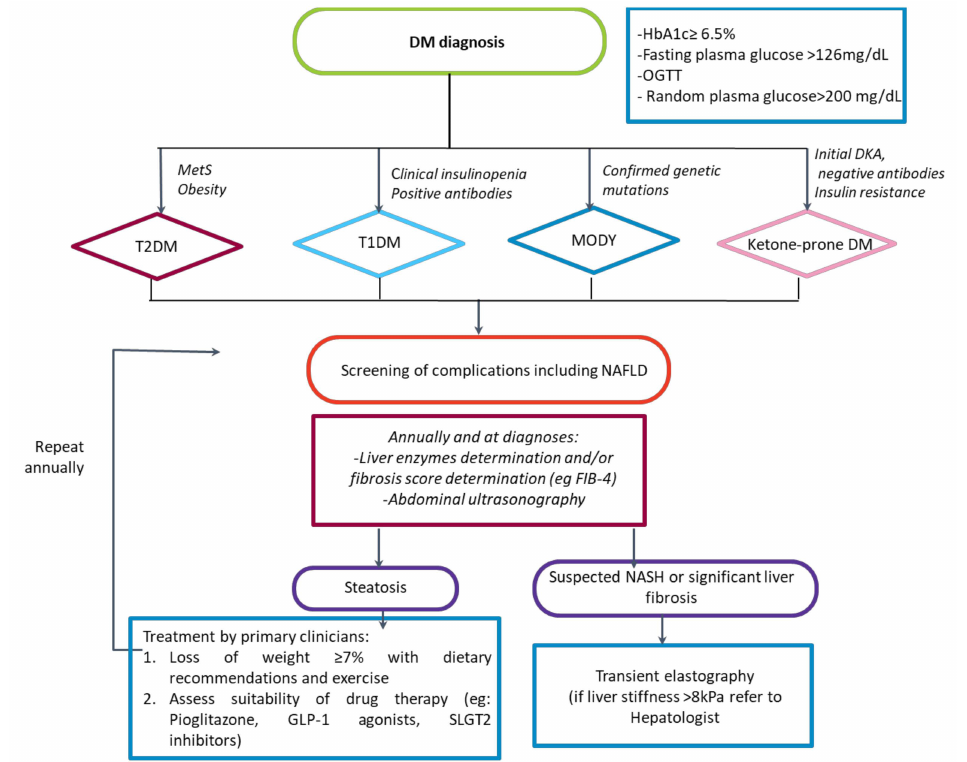
Figure 2. Algorithm proposed for the management of NAFLD in different typed of diabetes. DM: Diabetes mellitus; HbA1c: glycated hemoglobin; OGTT: Oral glucose tolerance test; MetS: Metabolic syndrome; T2DM: Type 2 diabetes mellitus; T1DM: Type 1 diabetes mellitus; MODY: Maturity- onset diabetes of the young; DKA: Diabetic ketoacidosis; OADs: Oral antidiabetic drugs; NAFLD: Non-alcoholic fatty liver disease; GLP1a: GLP-1 receptor